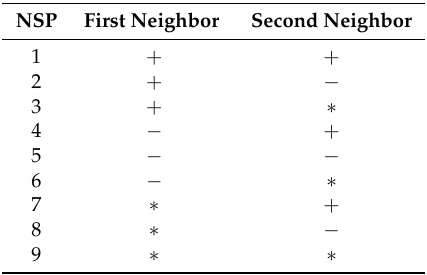
Table 1. The 9 Neighbor Sign Patterns (NSPs) for a 2-neighbors neighborhood. NSP First Neighbor Second Neighbor